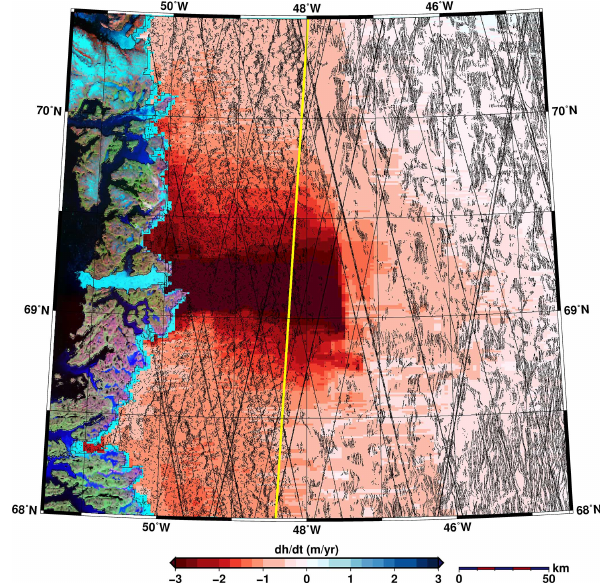
Figure 14. Jakobshavn Isbræ is experiencing massive thinning of more than 4myr − 1 . The thinning extends more than 250km inland. Data coverage of d h /d t measurements are shown for CryoSat-2 (gray) and ICESat (black). The yellow line running from north to south indicates the mode mask of CryoSat-2. To the west of this line SARIn and to the east LRM data were acquired. Unfortunately, CryoSat-2 show data loss in LRM zone of the catchment area of the glacier due to the high surface roughness and surface